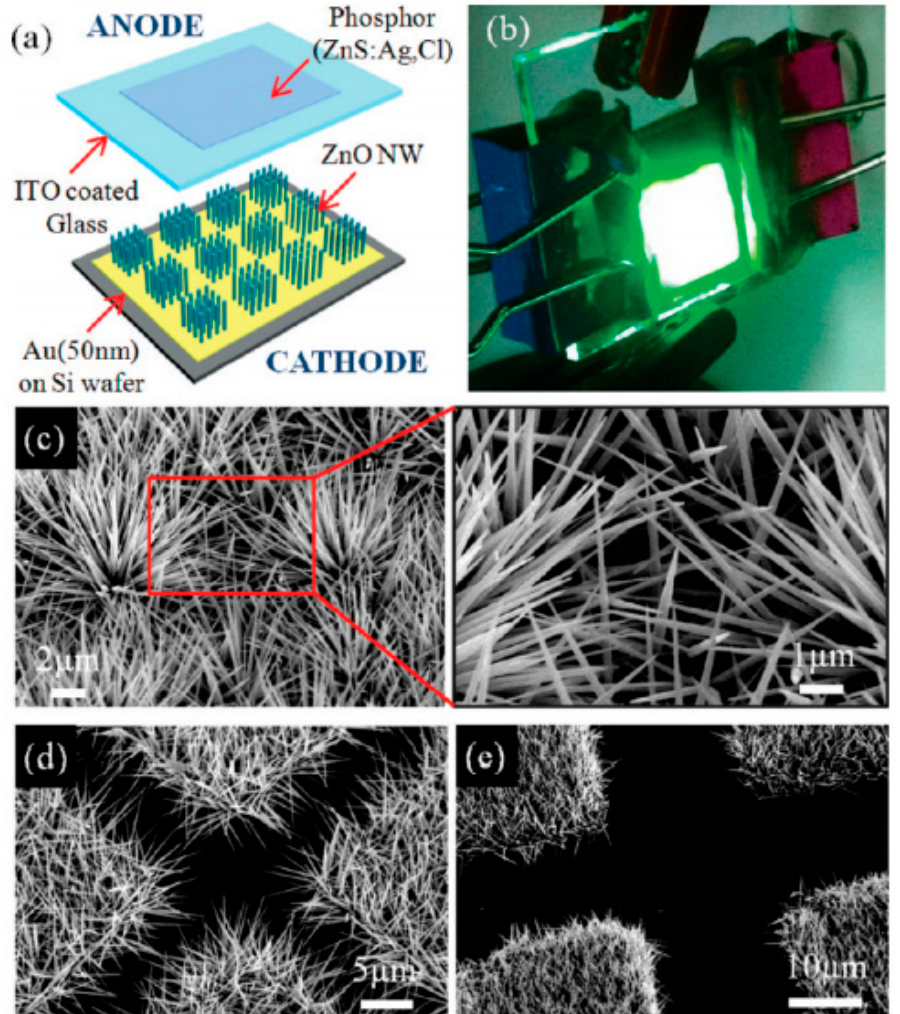
Figure 3. Demonstration of a diode field emission device based on hydrothermal-synthesized ZnO nanowires. ( a ) Schematic diagram and ( b ) optical image of the ZnO nanowires cold cathode. ( c – e ) scanning electron microscope (SEM) image of the nanowire arrays with different pattern spaces. Reproduced from [25], with the permission of ACS Publications, 2011.